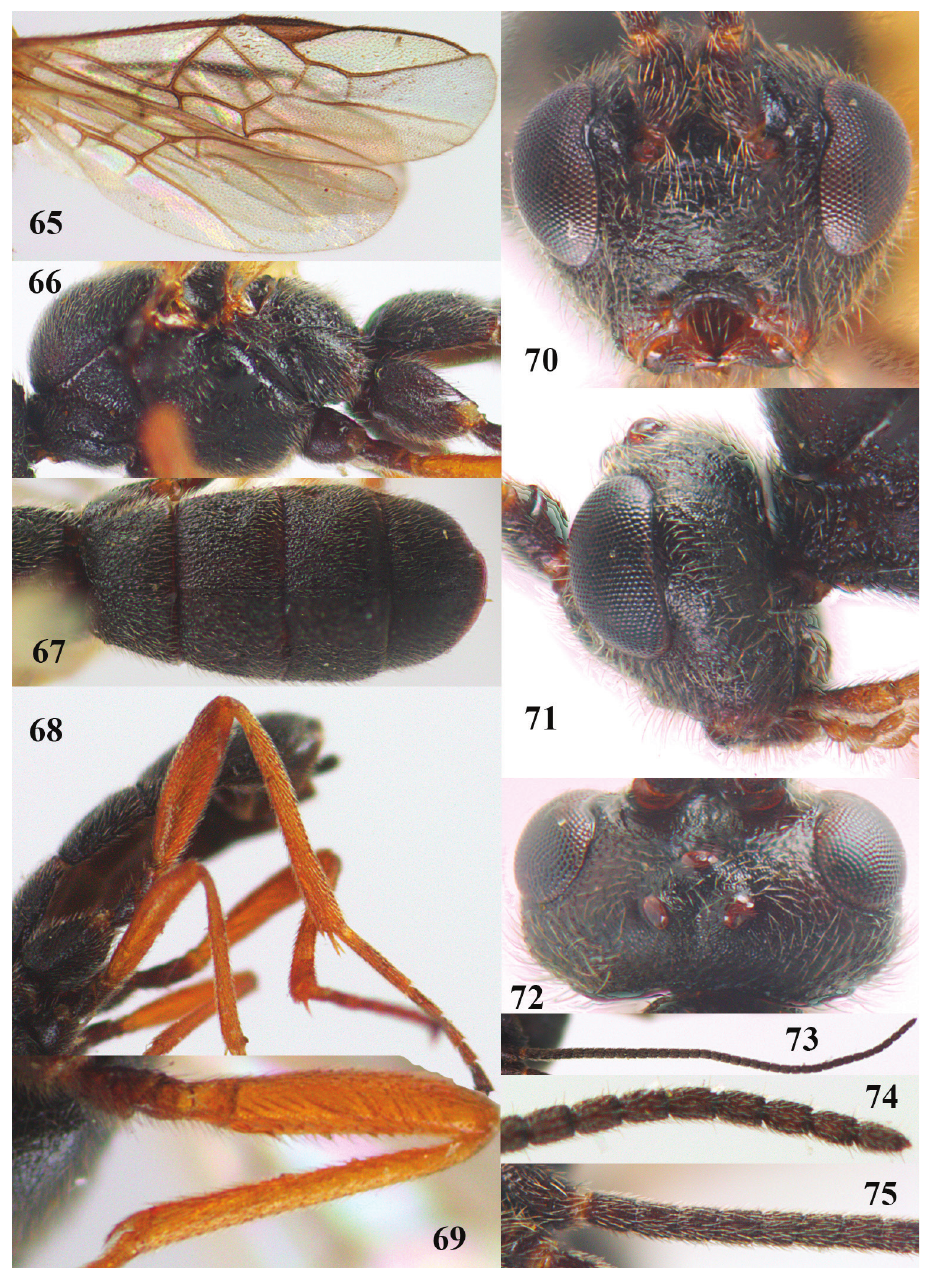
soma dorsal 68 hind leg lateral 69 fore femur lateral 70 head anterior 71 head lateral 72 head dorsal 73 antenna 74 apical segments of antenna 75 basal segments of